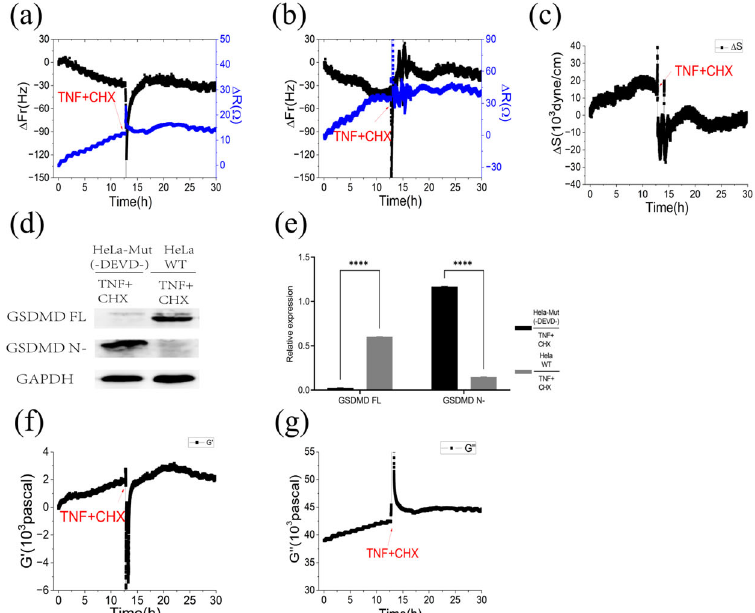
Figure 6. Dynamic QCM responses and cytomechanical parameters recorded during TNF and CHX induced pyroptosis in 2000 GSDMD − / − -DEVD- mutant expressing HeLa cells. ( a , b ) Frequency shifts and motional resistance changes on AT ( a ) and BT ( b ) cut quartz crystals; ( c ) Cells generated force on quartz crystal; ( d ) Switch of TNF induced apoptosis to pyroptosis by caspase-3 sensitive GSDMD mutant. GSDMD-DEVD- (replacement of the FLTD motif with the caspase-3-cleavage site DEVD) was stably expressed in HeLa GSDMD − / − cells. Cells were treated with TNF and CHX for 8 h, GSDMD was proteolytically cleaved into specific size, GSDMD N- can then be detected upon TNF and CHX stimulation through Western Blot assay. GAPDH expression is the loading control; ( e ): The relative expression of target protein/GAPDH was analysed by Image-Pro Plus 6.0 Software (**** p < 0.0001); ( f ) Variations in the elastic modulus (storage modulus) G ′ ; ( g ) Variations in the viscous modulus (loss modulus) G ″ .